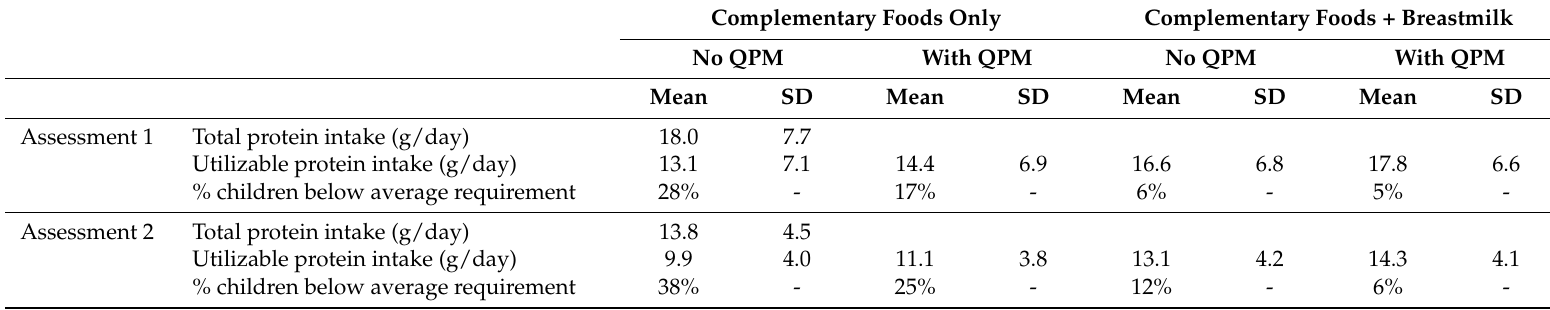
Table 4. Total and utilizable protein intakes and protein inadequacy, accounting for breastfeeding and simulated substitution of conventional maize with quality protein maize